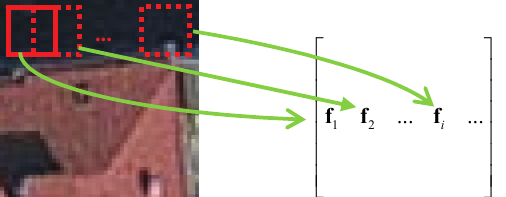
Figure 9. Demonstration of dense local feature computed in an image patch. The feature is computed in the red sliding window, and the local features are denoted as